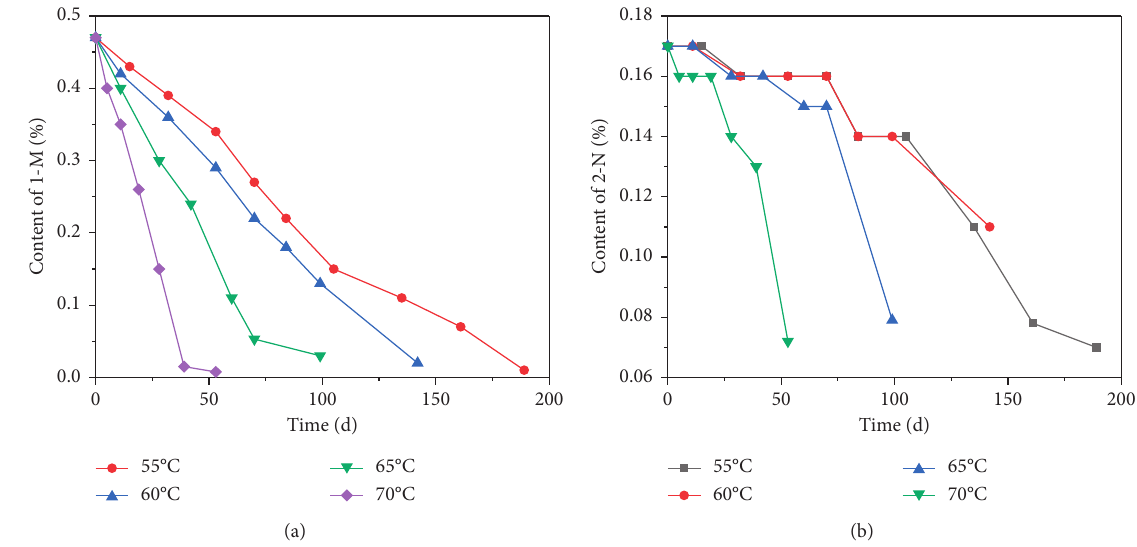
Figure 2: The content of the stabilizer at different storage temperatures.